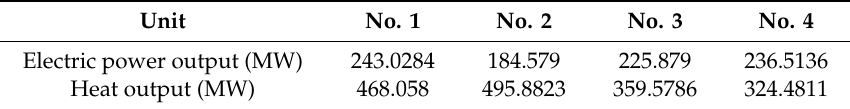
Table A2. Operating parameters of